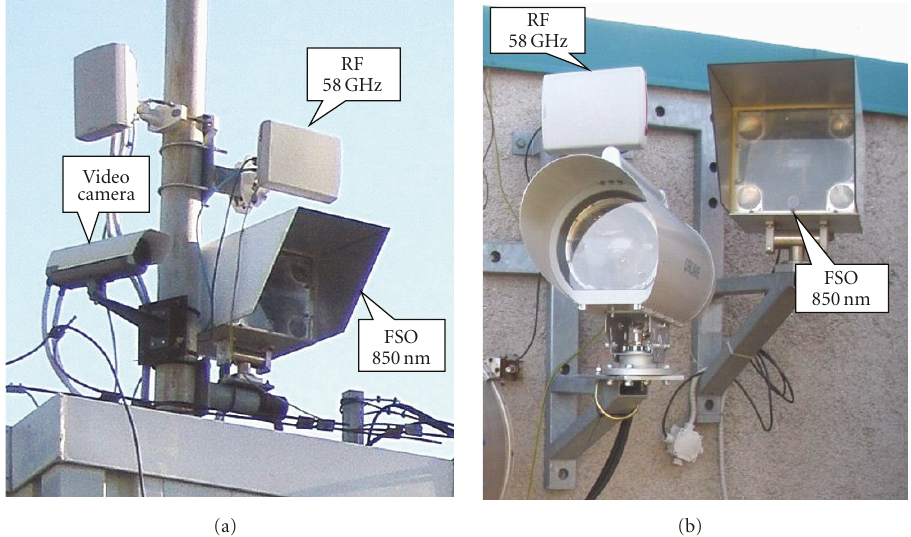
Figure 1: FSO system, RF system, and video camera at CMI (a); FSO system and RF system at IAP AS CR (b).